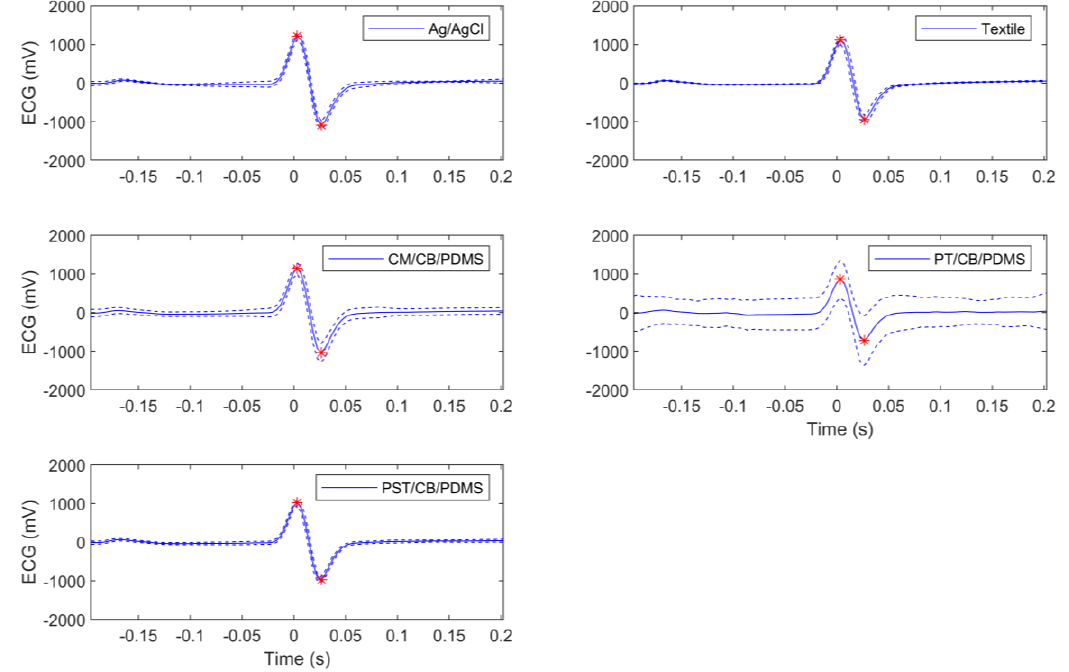
Figure 7. ECG templates for a given subject. Solid line is the resulting template. Dotted lines represent mean ± one standard deviation. Red marks represent maximum and minimum values of reference to compute peak-to-peak amplitude.